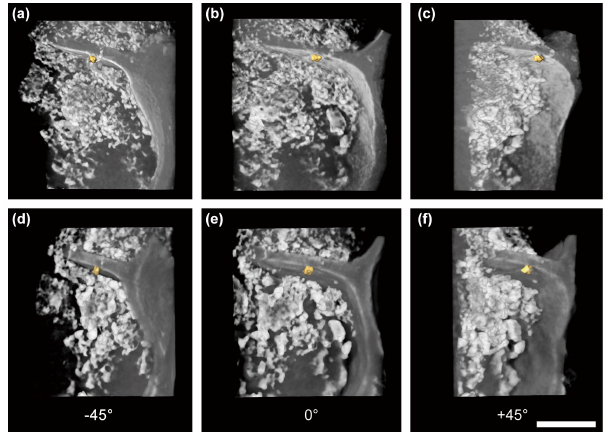
Figure 3. 3-D tomography illustration of laboratory-made BC and the mineral nanoparticle consortium observed at − 45 ◦ (a, d) , 0 ◦ (b, e) , and + 45 ◦ (c, f) azimuthal viewing angles under absorption contrast (a, b, c) and phase contrast mode (d, e, f) . The scale bar is 5µm.